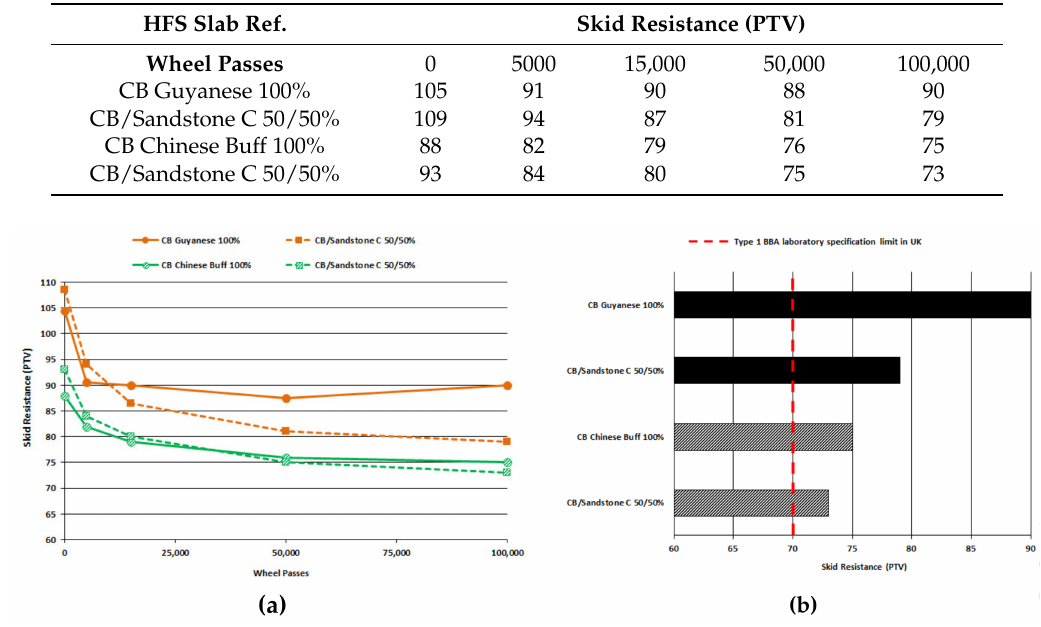
Figure 10. ( a ) Skid resistance development up to 100,000 wheel-passes; ( b ) skid resistance ranking after 100,000 wheel-passes (Ulster University